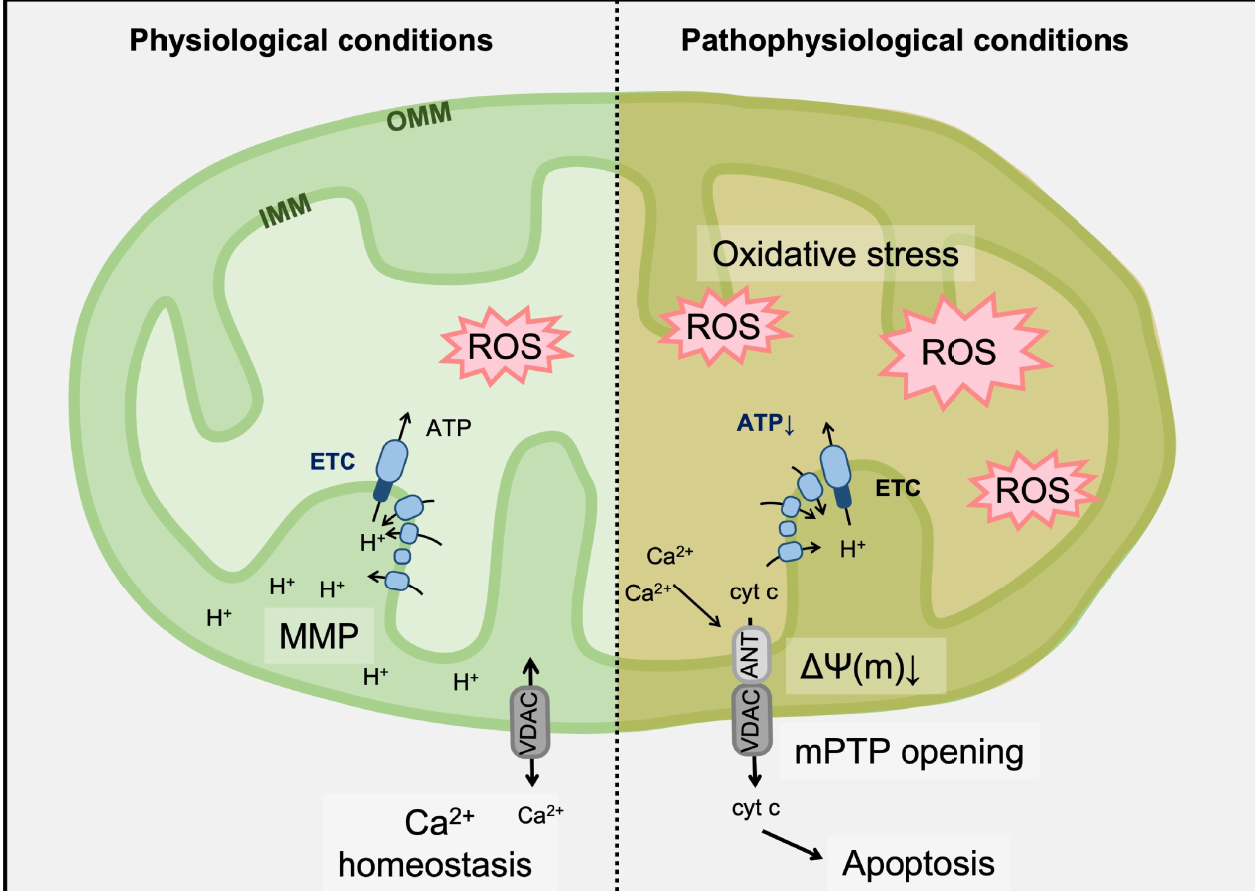
Figure 3. Regulation of mitochondrial permeability transition pore (mPTP) for maintaining mitochon- dria homeostasis. mPTP is a protein complex present between the inner mitochondrial membrane (IMM) and outer mitochondrial membrane (OMM). The mPTP is composed of a voltage-dependent anion channel (VDAC) and adenine nucleoside translocator protein (ANT) that act to regulate MMP for mitochondria homeostasis. Under pathophysiological conditions, excessive Ca 2+ and ROS induce mPTP opening and cause mitochondrial-related